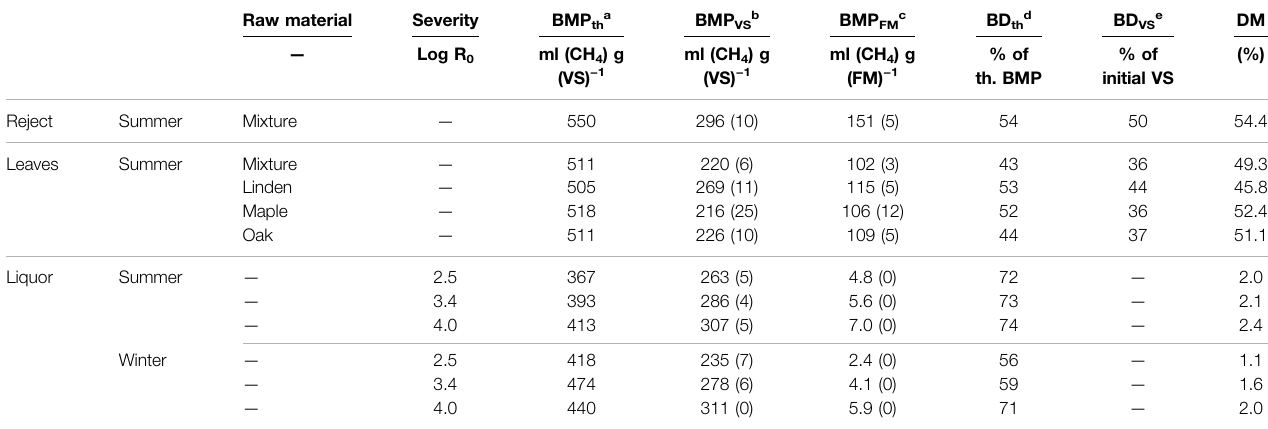
TABLE 4 | Results for biomethane potentials (BMP) and for biodegradability (BD) of fi ne sieving rejects, leaves, and liquor fractions from steam re fi ning using different severities (log R 0 ) and the dry matter (DM) content of the substrate (without inoculum) (SD in parenthesis). Raw